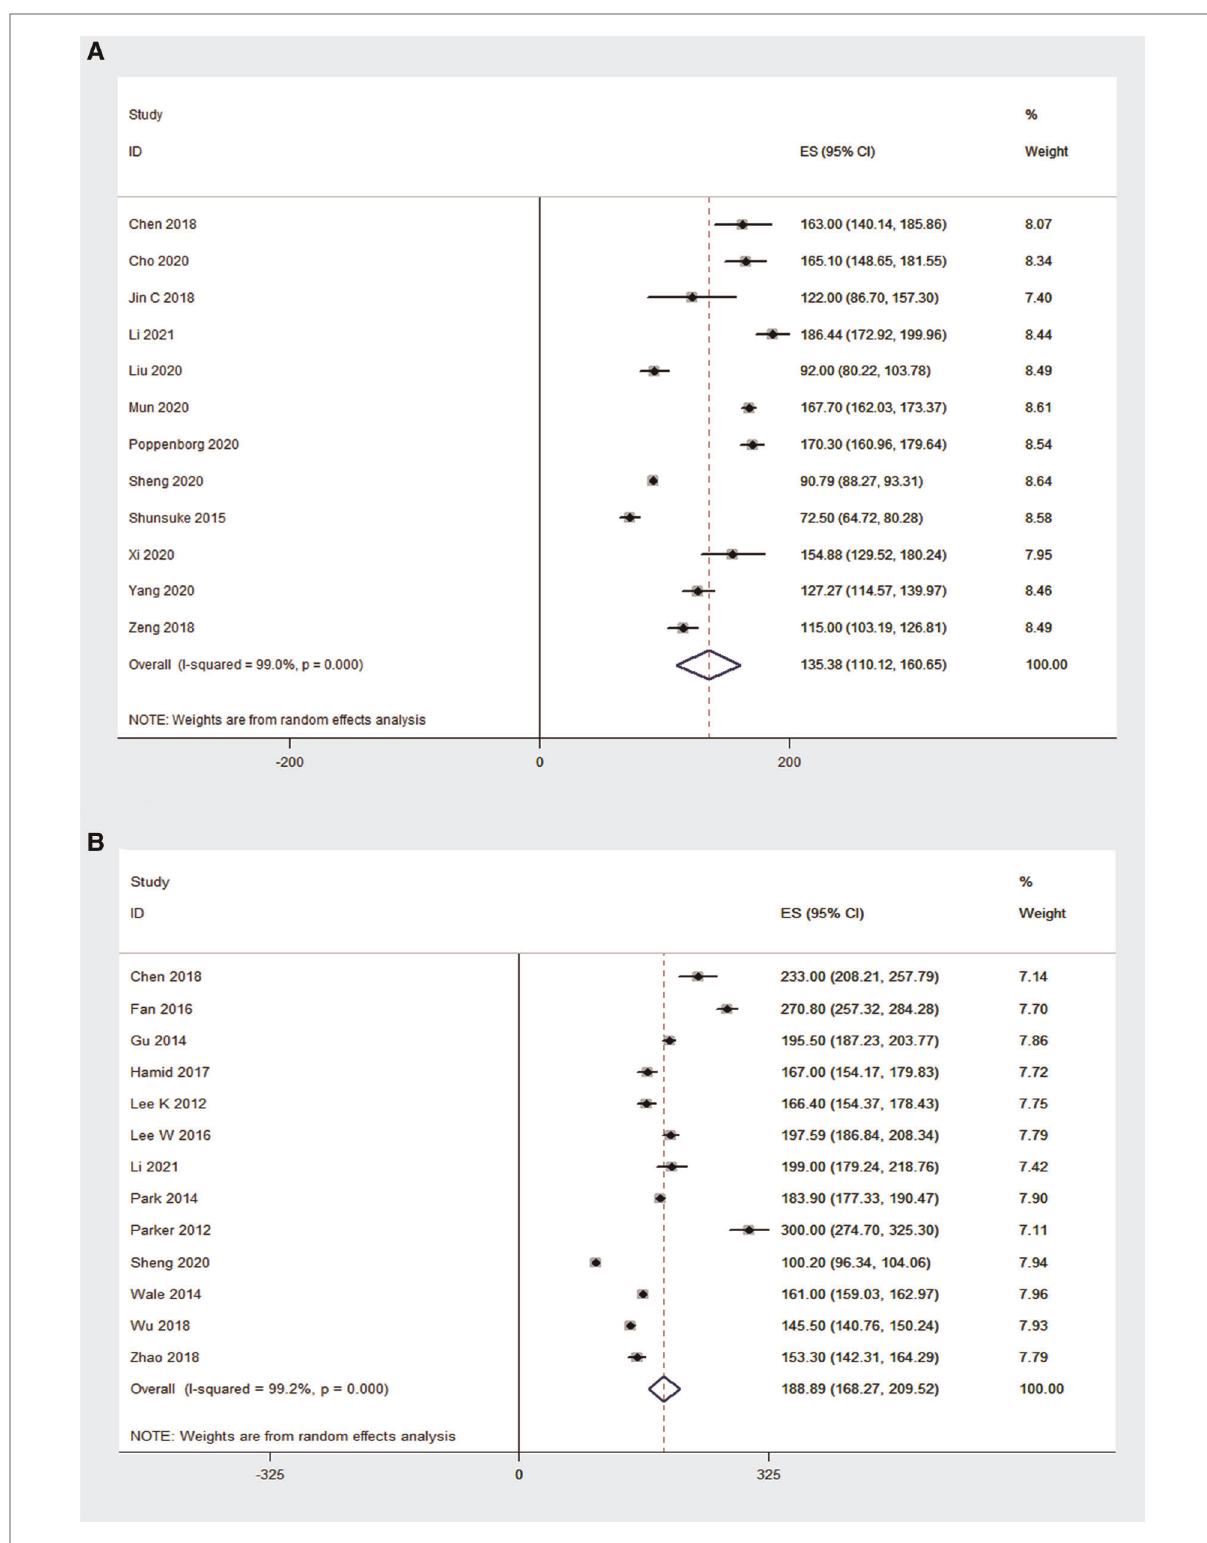
FIGURE 3 Forest plot and pooled estimates of operative time. Outcomes assessed are ( A ) OLIF group; ( B ) MI-TLIF